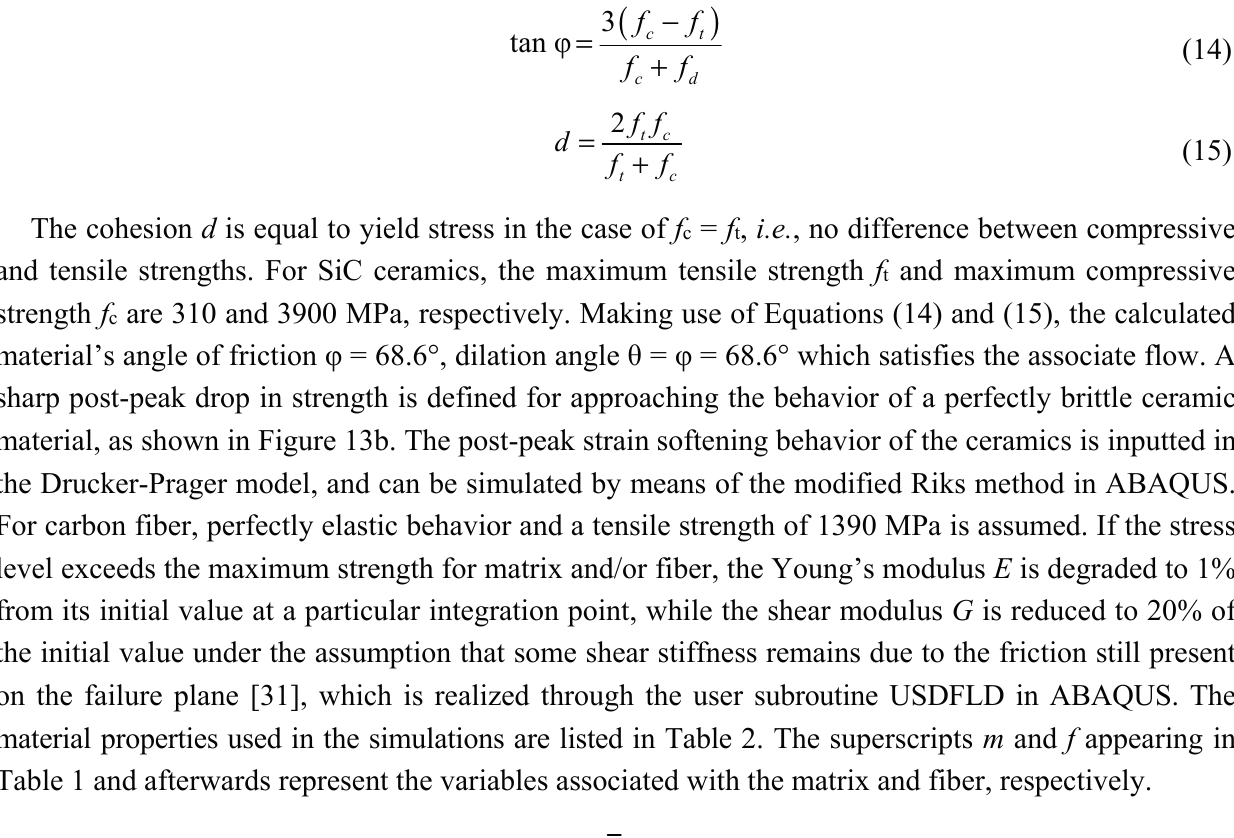
Figure 13. ( a ) Yield surfaces in the p - σ plane in the Drucker-Prager model; and ( b ) uniaxial stress-strain